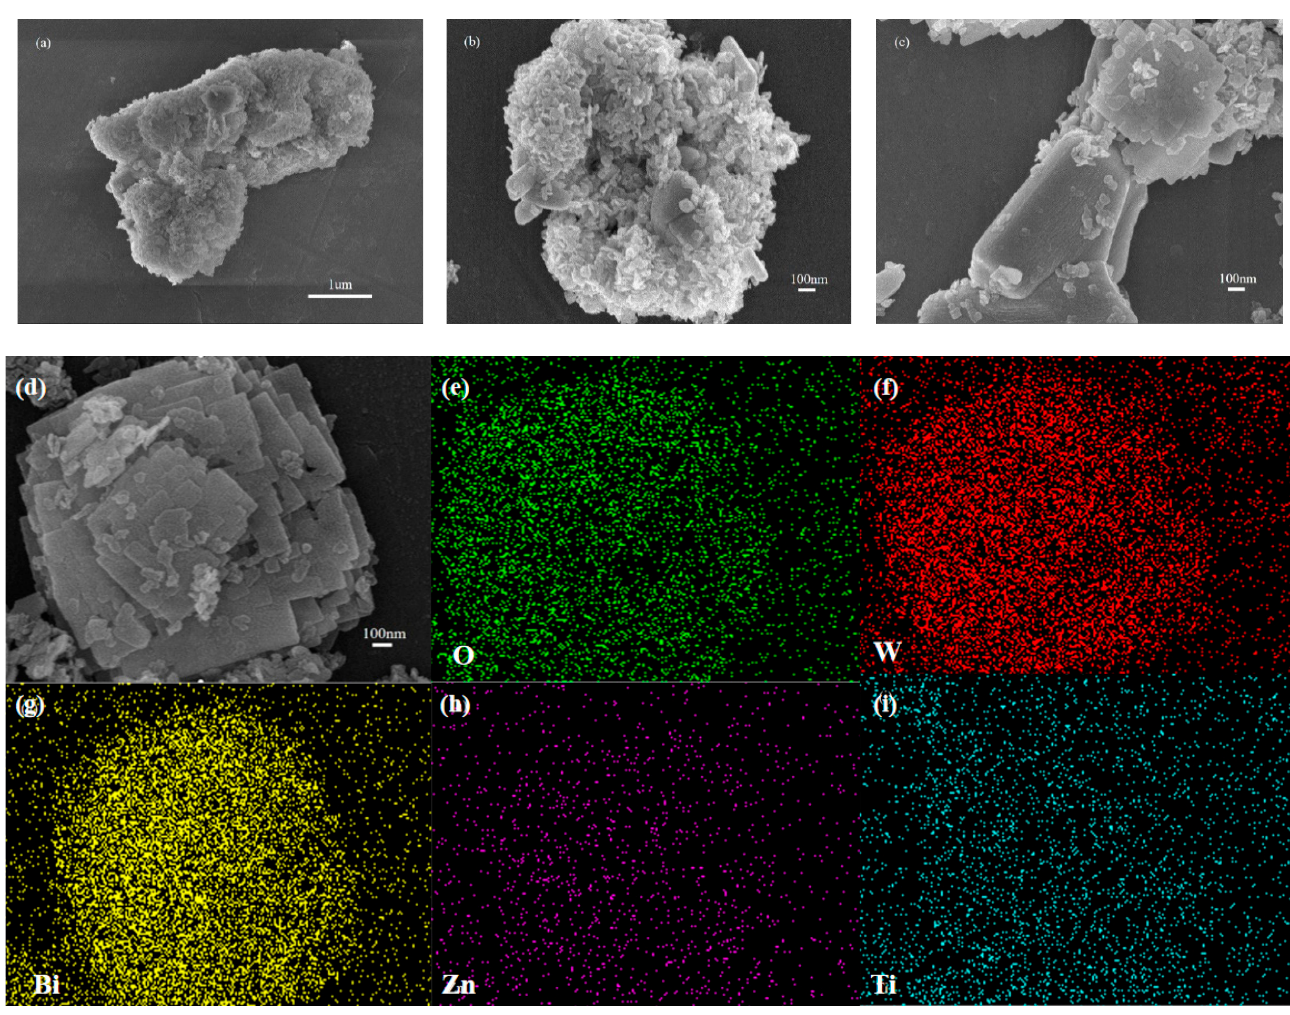
Figure 2. ( a , b ) SEM images of the ZnTiO 3 sample; ( c , d ) SEM images of the ZnTiO 3 /Bi 2 WO 6 hetero- junction sample inset in ( d ): EDX of the ZnTiO 3 /Bi 2 WO 6 heterojunction sample; and the elemental O ( e ), W ( f ), Bi ( g ), Zn ( h ), and Ti ( i ) mapping of the ZnTiO 3 /Bi 2 WO 6 heterojunction sample.